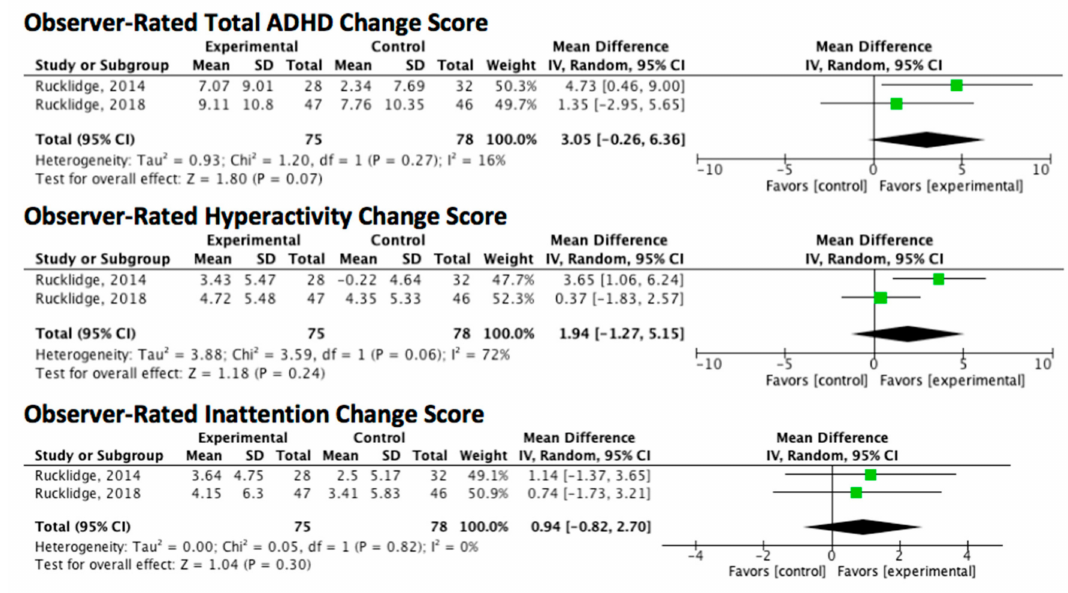
Figure 5. Forest plots of meta-analysis of ADHD